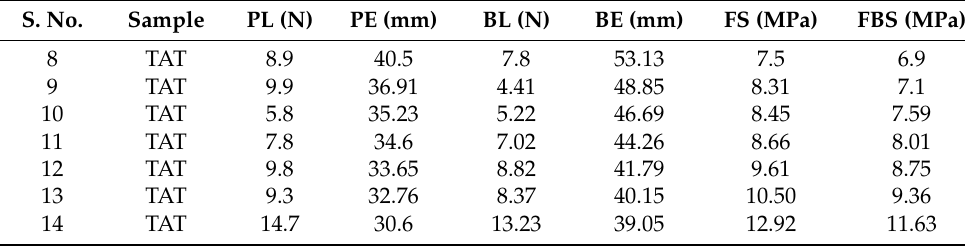
Table 6. Flexural testing results for TAT (TPU: ABS: TPU) specimens (sample no 8–14). S.